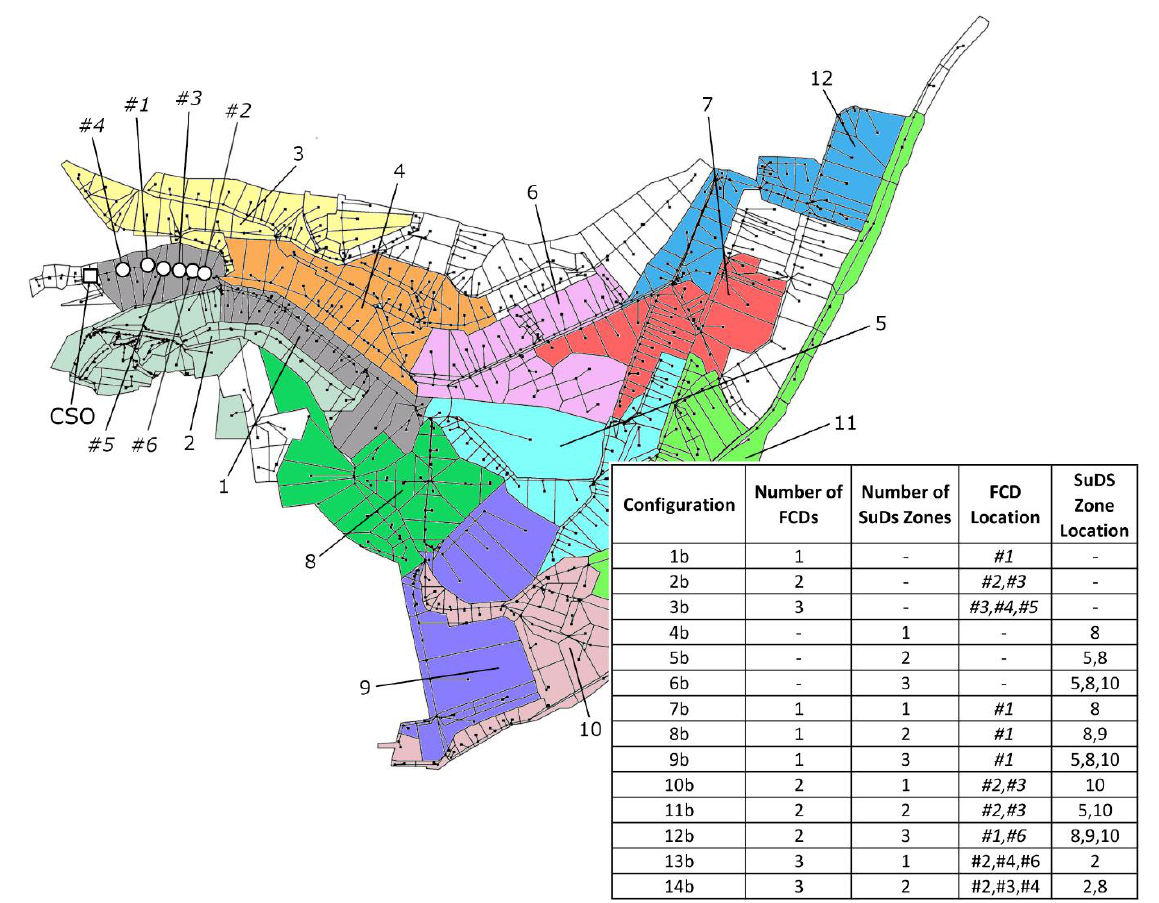
Figure 6. Optimal FCD and/or SuDS locations selected by the GA in the Zona Central catchment.